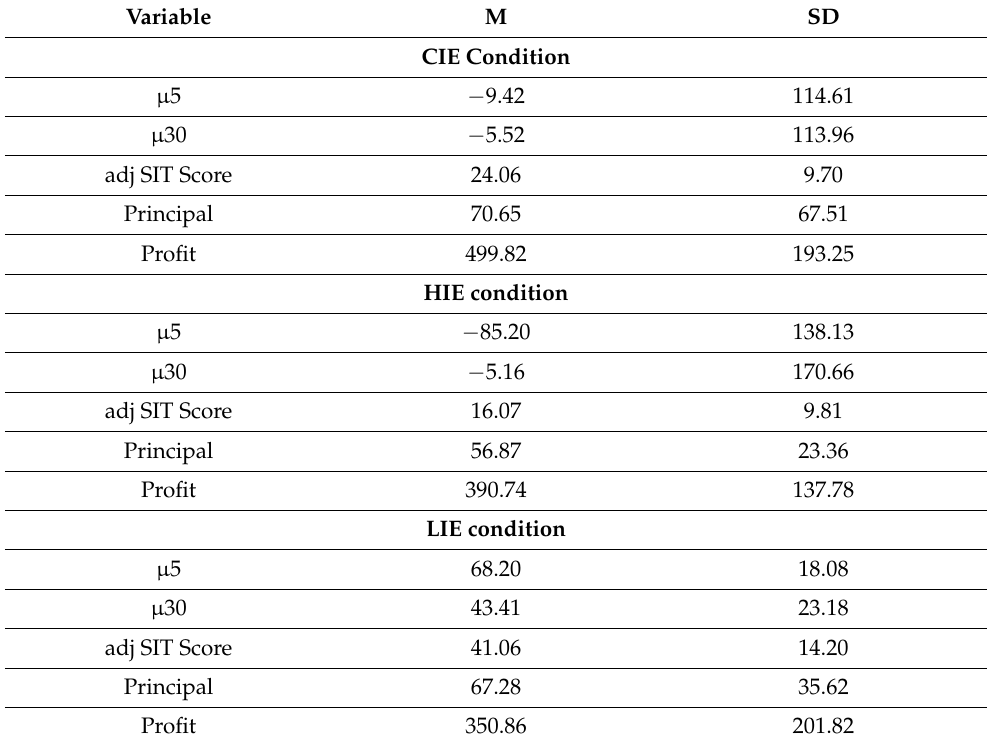
Table 3. Means and variances for each variable ( N =